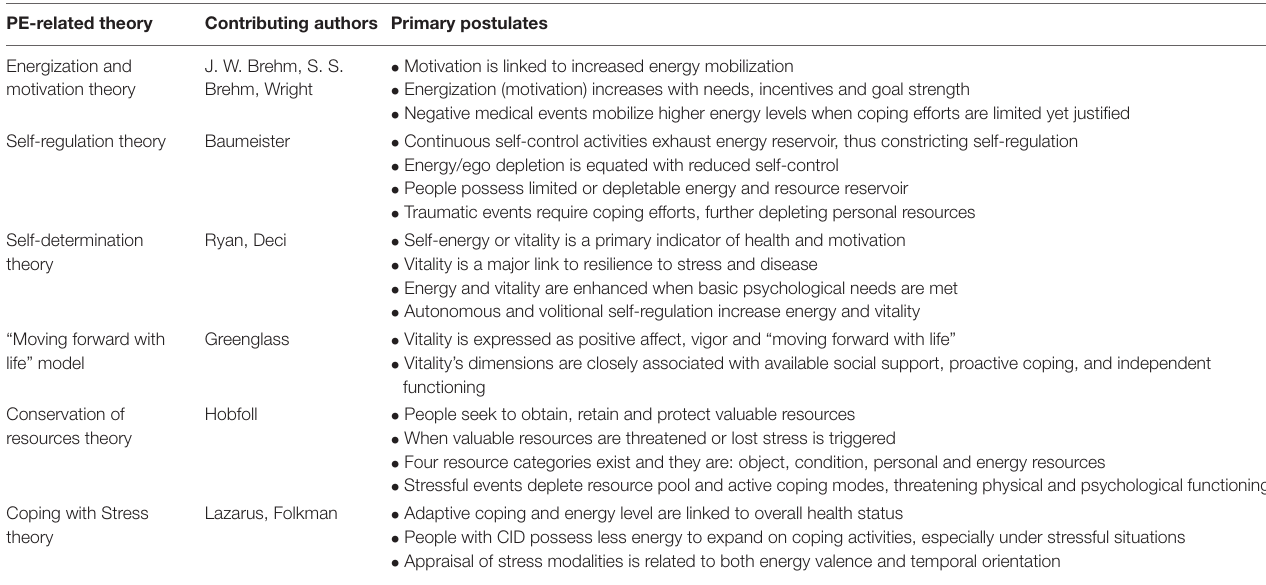
TABLE 1 | Selected psychological energy theories and their main